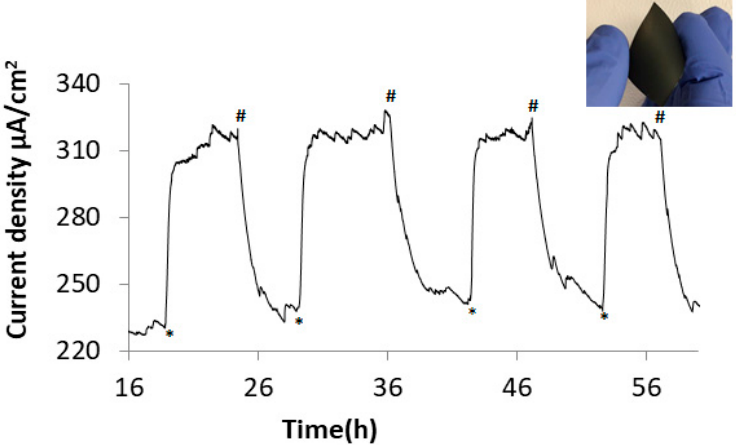
Figure 4. Electro-catalytic performance in oxygen generation from water, with and without light illumination (0.25 sun), of flexible ITO-PET plastic sheets coated with a thin film of PEDOT/nano Co 3 O 4 /rGO nanocomposites, where the polymerization mixture used to fabricate the nanocomposite contained 110 mg of nano Co 3 O 4 and 2.0 mg of rGO. Conditions: applied bias on the nanocomposite electrode of 0.80 V (vs. Ag/AgCl) in 0.2 M Na 2 SO 4 (pH 12) (* = ‘light on’, # = ‘light off’). The inset depicts a photograph of the electrode.